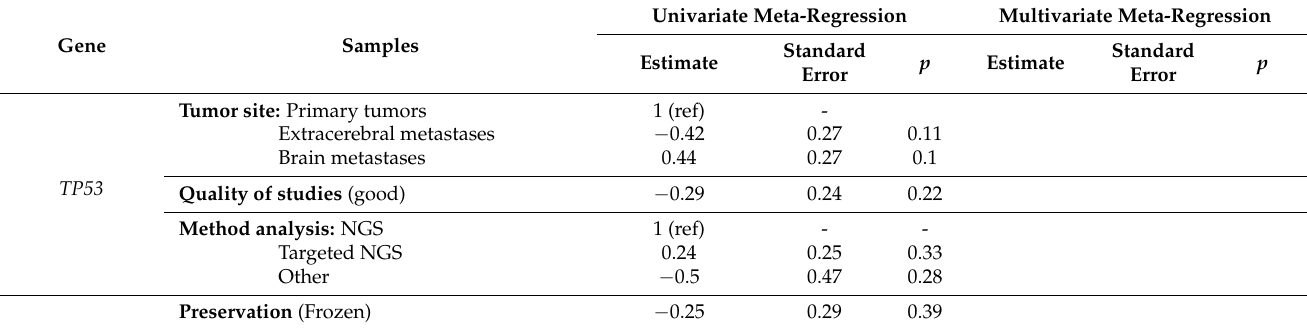
Table 2. Univariate and multivariate